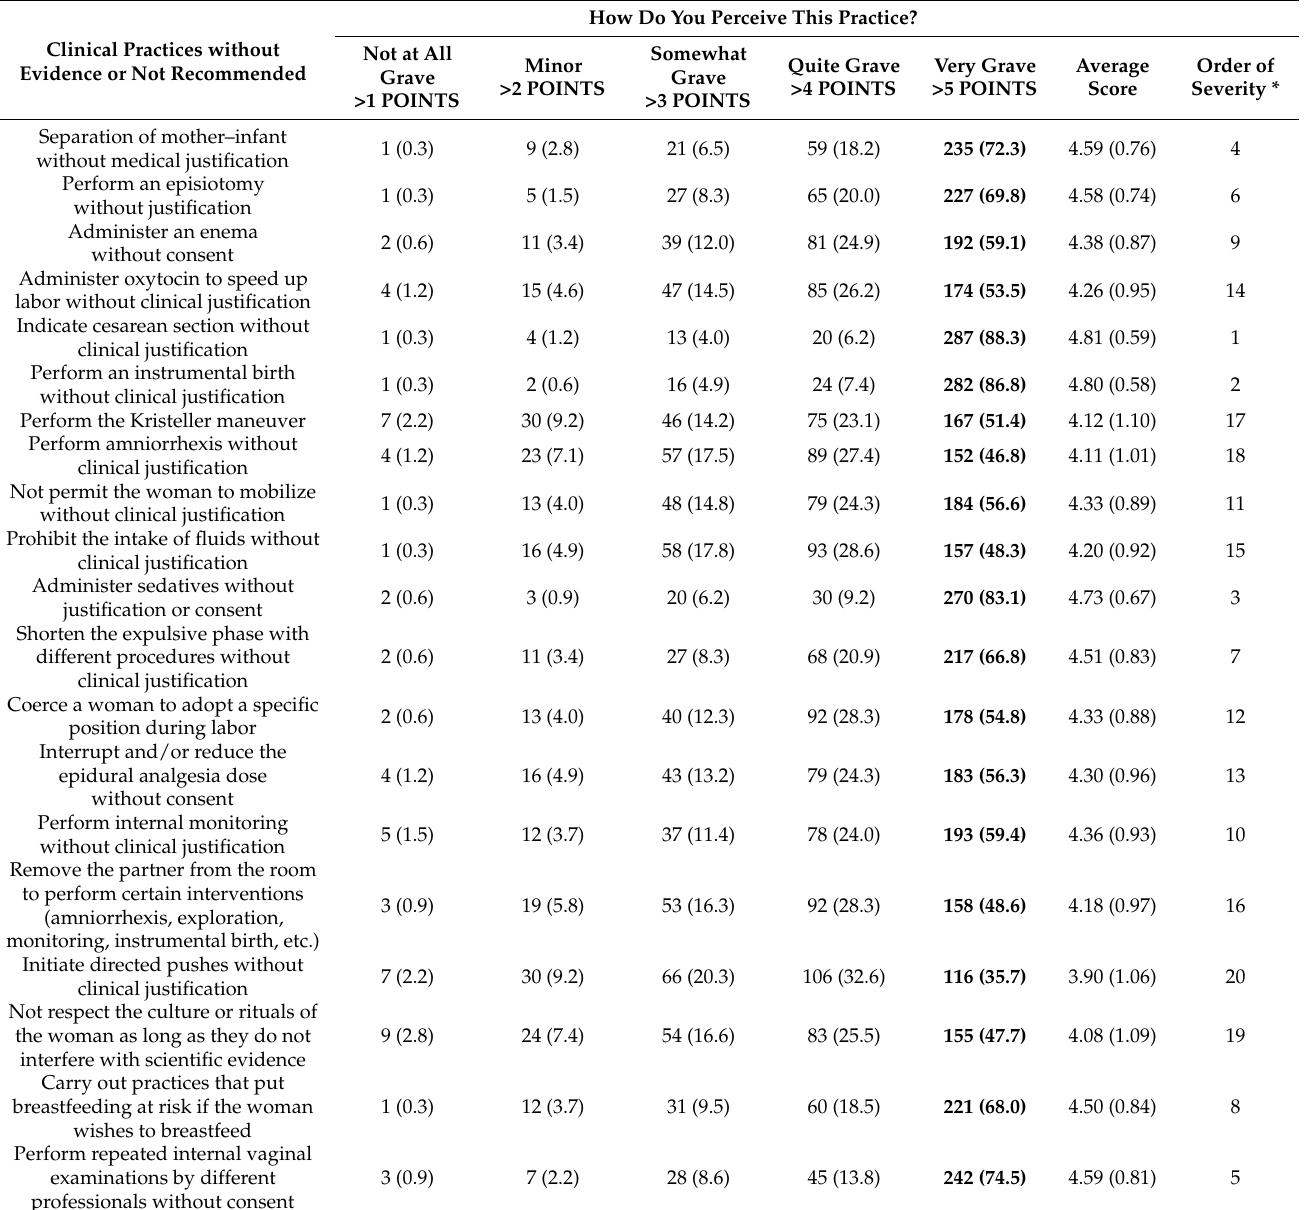
Table 5. Assessment by midwives of the degree of OV severity of different clinical practices not recommended by scientific